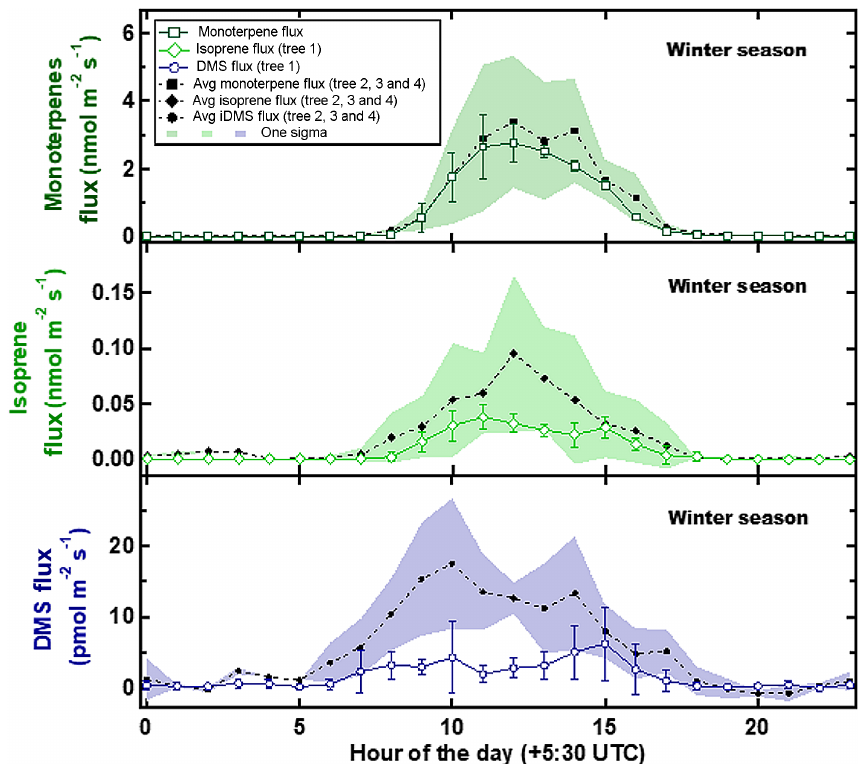
Figure 1. Average wintertime emission fluxes and variability (as standard deviation) for trees 2, 3 and 4 shown in comparison to average flux and variability of tree 1.